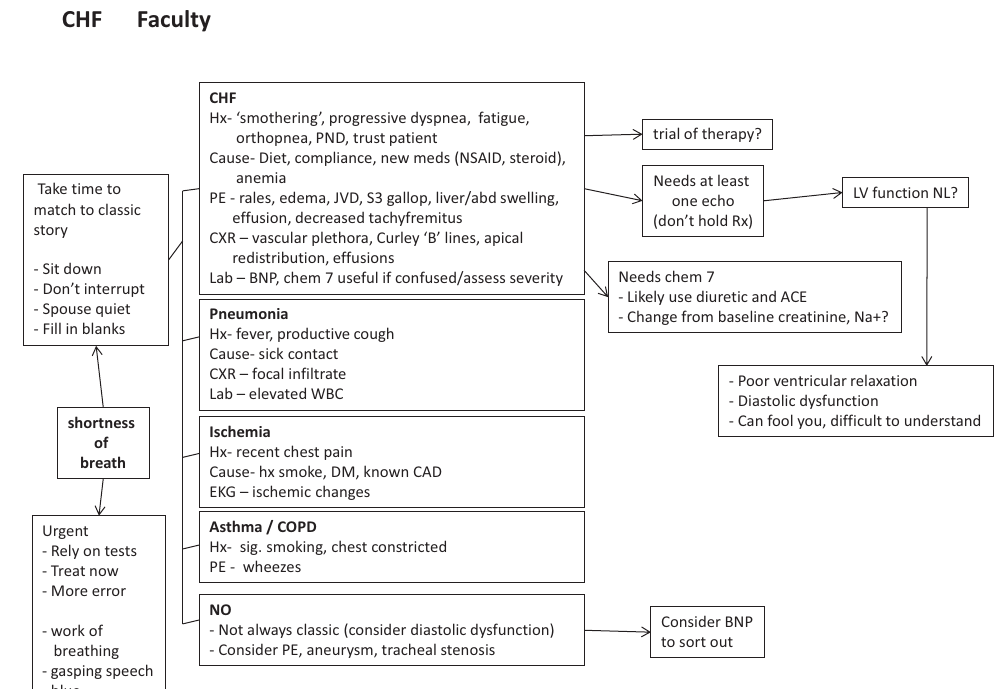
Figure A5. Experienced